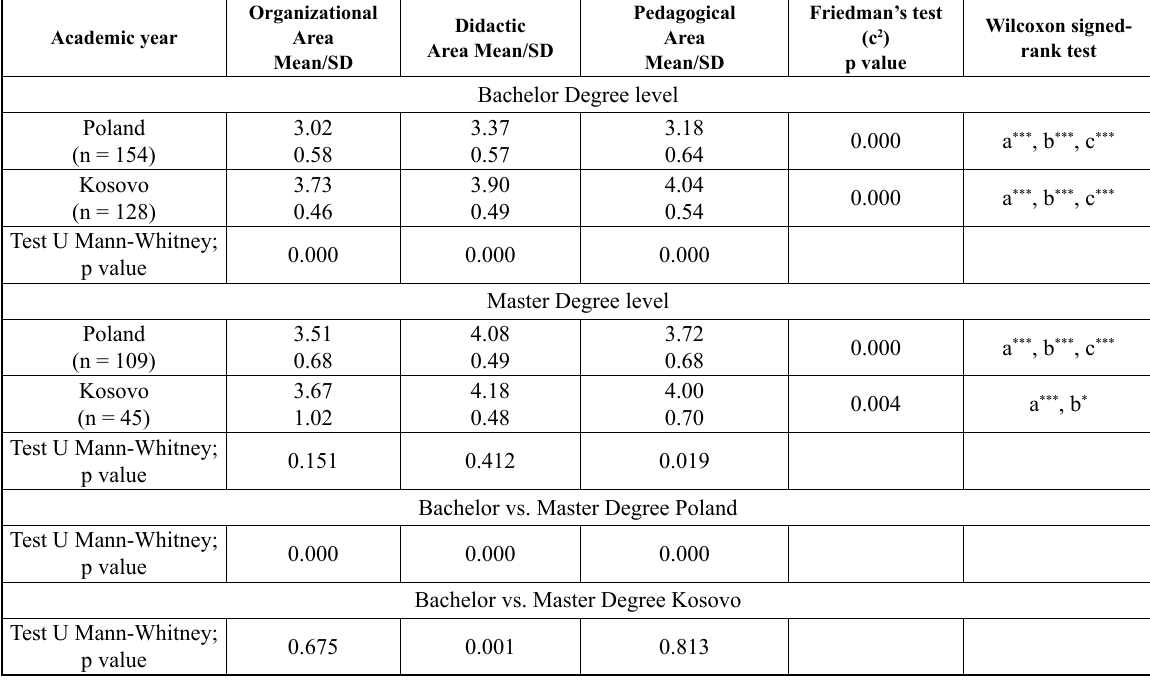
Table 1. Mean scores and standard deviations of Physical Education students from Poland and Kosovo in organizational, didactic and pedagogical